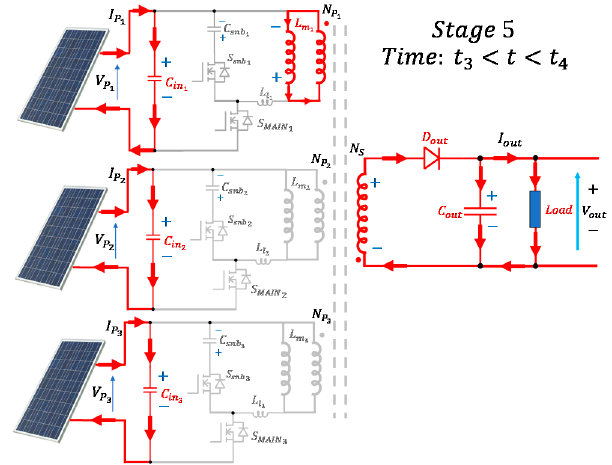
In Figure 6, 𝑆 (cid:3014)(cid:3002)(cid:3010)(cid:3015)(cid:2869) and 𝑆 (cid:3046)(cid:3041)(cid:3029)(cid:2869) are turned off. The output diode current decreases to zero at 𝑡 = 𝑡 (cid:2872) . The output diode turn-on time is defined by Equation (13). Figure 5. Stage 4, time: 𝑡 (cid:2870) < 𝑡 < 𝑡 (cid:2871) . Figure 5. Stage 4, time: t 2 < t < t 3 .